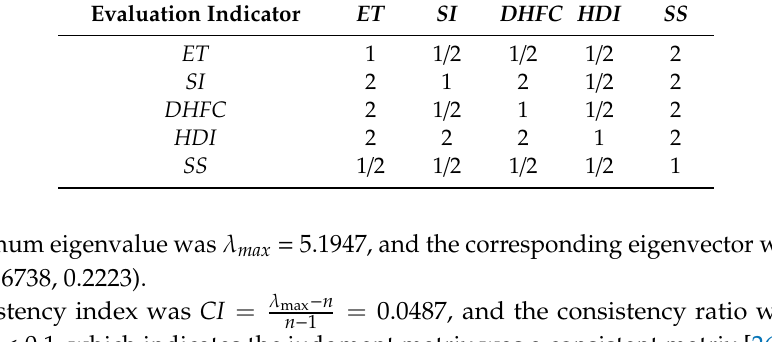
Table 1. Judgment matrix of evaluation indicator of a casting workshop. Evaluation Indicator ET SI DHFC HDI